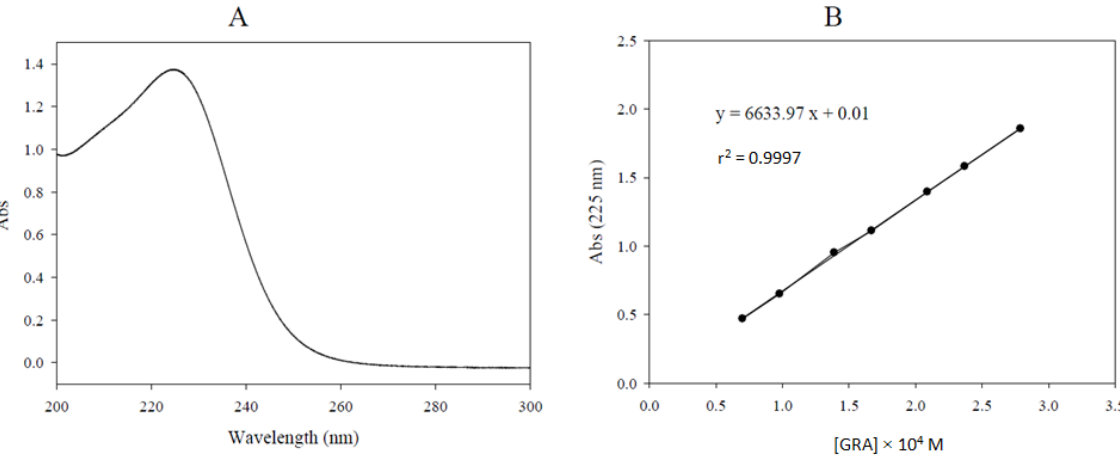
Figure 2. UV spectrum of purified glucoraphanin (GRA) (purity 95%) in water at a concentration value of 2.089 × 10 − 4 M. λ : 225 nm ( A ). Absorbance vs. glucoraphanin max (GRA) concentration plot used for the determination of the molar extinction coefficient ( ε ) in water at 225 nm. The ε calculated by linear regression as the slope of the plot resulted 6634 M − 1 cm − 1 ( B